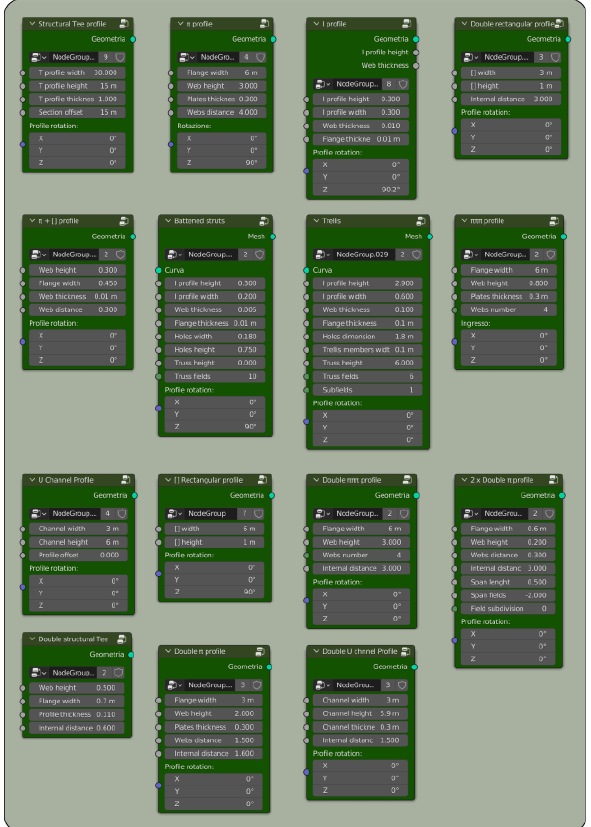
Figure 5 . The VPL algorithm’s architecture. Figure 6 . The sections library in Blender Geometry Nodes.